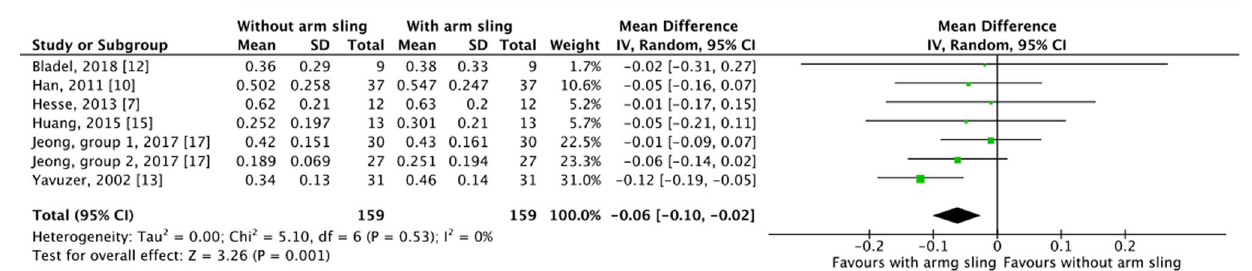
Figure 2. Forest plot for walking speed comparison, standard mean difference.